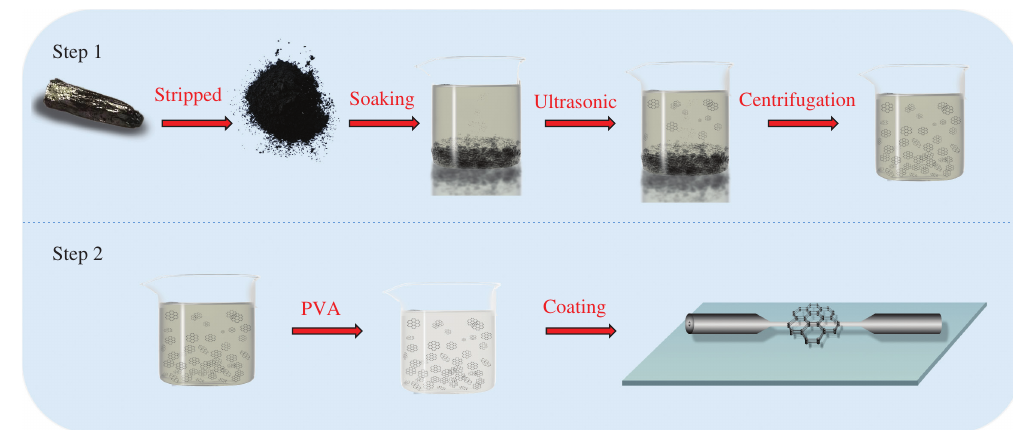
Figure 1: Preparation processes of few-layer tellurene nanosheets and tellurene-based SA.